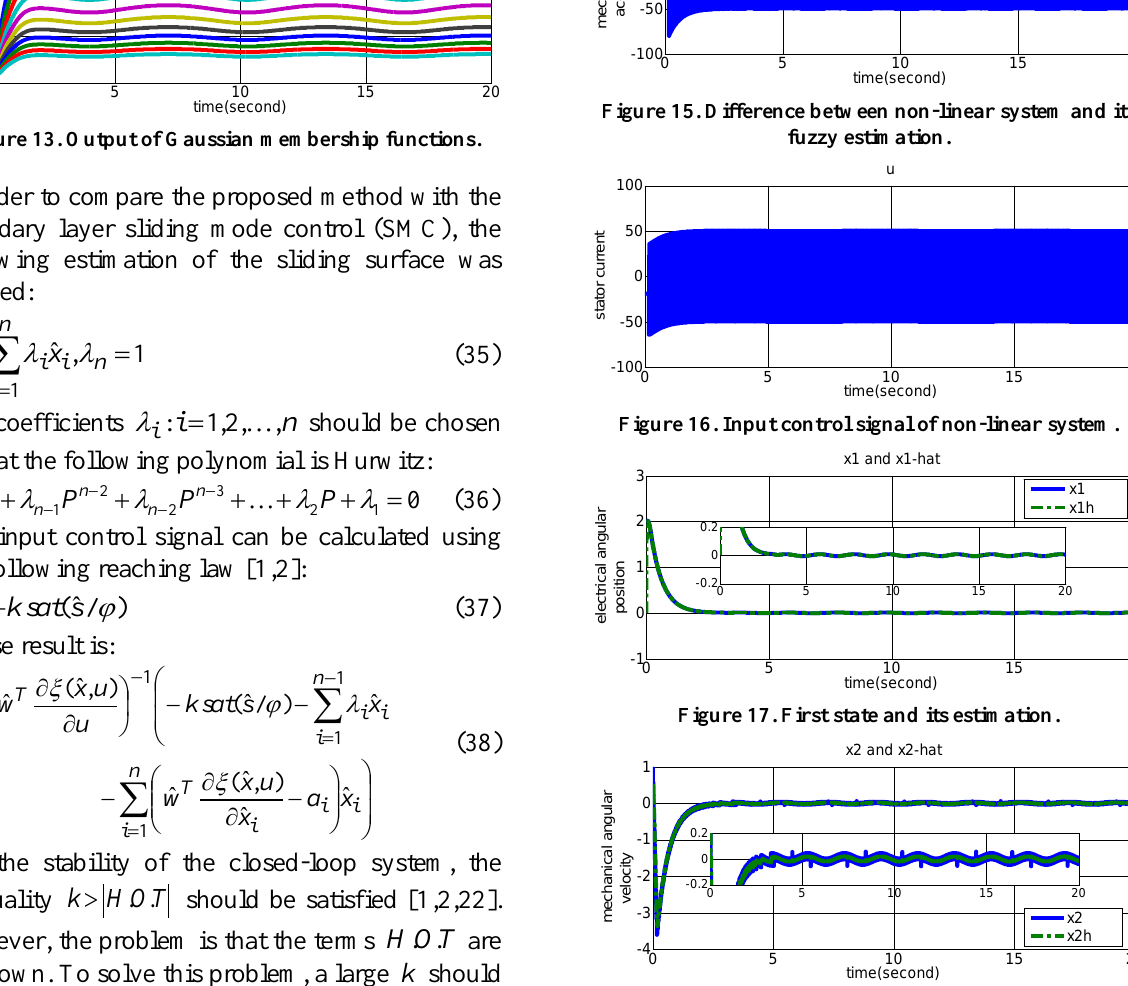
Figure 12. Adaptive weight of fuzzy system.